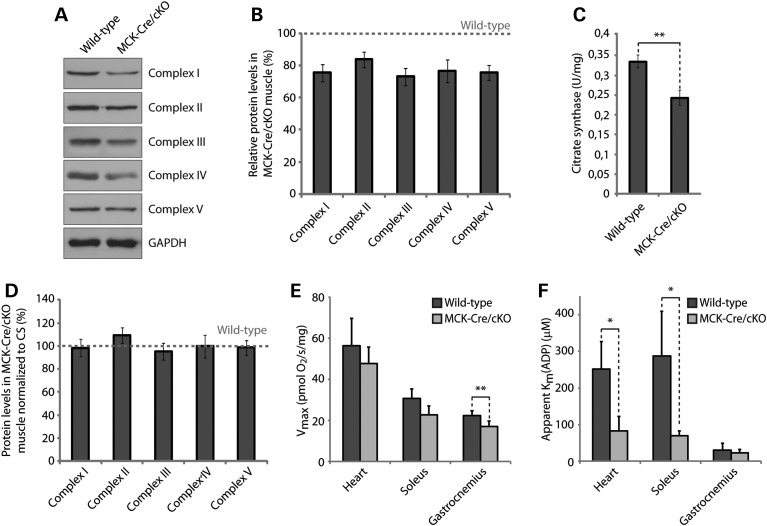
Reduced expression levels of mitochondrial proteins and impaired respiratory function of MCK-Cre/cKO muscle. (A) Equal amounts of wild-type and plectin-deficient gastrocnemius muscle lysates were subjected to immunoblotting using antibodies as indicated. GAPDH was used as loading control. (B) Signal intensities of immunoblots as shown in (A) were densitometrically measured and normalized to total protein content as analyzed by the Coomassie staining (not shown). Mean values ± SEM, three experiments. Note that the reduced protein levels observed in MCK-Cre/cKO lysates were statistically significant for all mitochondrial respiratory complex proteins assessed (Complexes II and IV, P < 0.05; Complexes I, III and V, P < 0.01). (C) CS activity was measured in wild-type and MCK-Cre/cKO gastrocnemius muscle lysates prepared from 12-week-old mice. Mean values ± SEM, four experiments. (D) Relative protein levels as assessed in (B) were normalized to respective CS activity levels as determined in (C). Note that overall protein levels of respiratory complex subunit proteins per mitochondrion remained unchanged in plectin-deficient muscle. (E) Respiratory capacities of mitochondria (per milligram wet weight) in permeabilized muscle fibers isolated from heart, soleus or gastrocnemius muscles from wild-type and MCK-Cre/cKO mice. Mean ± SD, three experiments. (F) Apparent Km for ADP (KmADP, affinity of mitochondrial respiration to ADP) in permeabilized muscle fibers isolated from heart, soleus or gastrocnemius muscles from wild-type and MCK-Cre/cKO mice. Mean ± SD, three experiments.